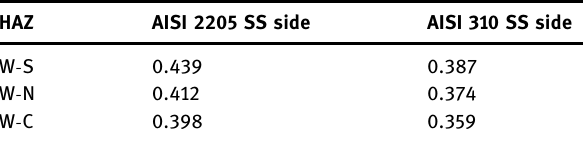
Table 5: Width of HAZ for the joints ( in cm )